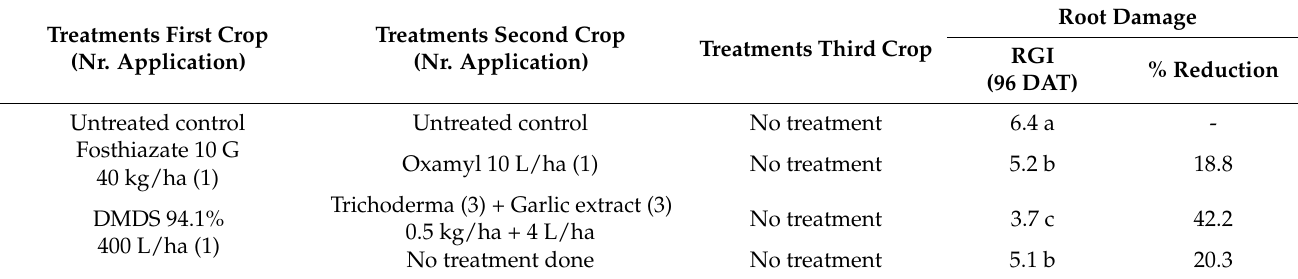
Table 5. Efficacy of DMDS alone and its strategies with biopesticides in controlling the root-knot nematode ( M. arenaria ) on the third crop of cucumber that did not receive any treatment before it. Summer–autumn cycle (July–October 2019). Treatments First